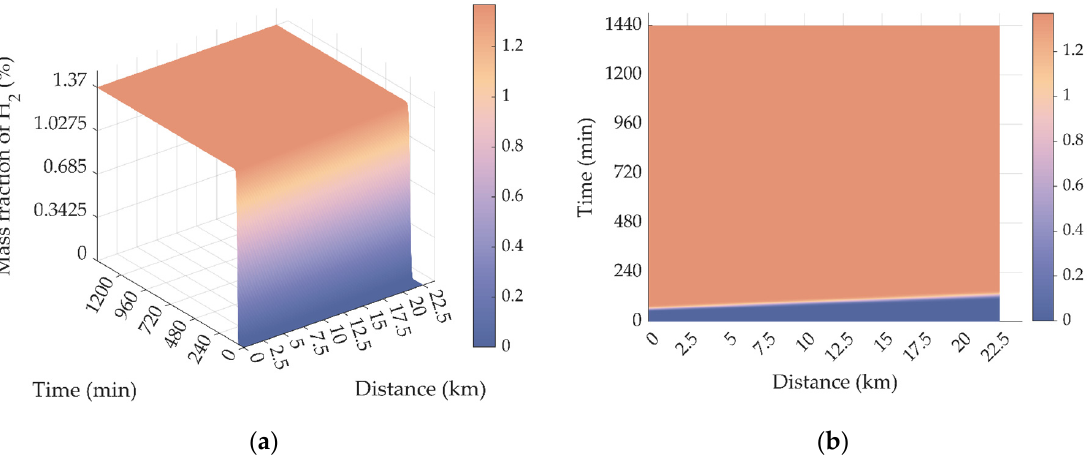
Figure 9. The distribution of hydrogen mass fraction in Pipe 2 in Scenario I: ( a ) Three-dimensional diagram; ( b ) top view.